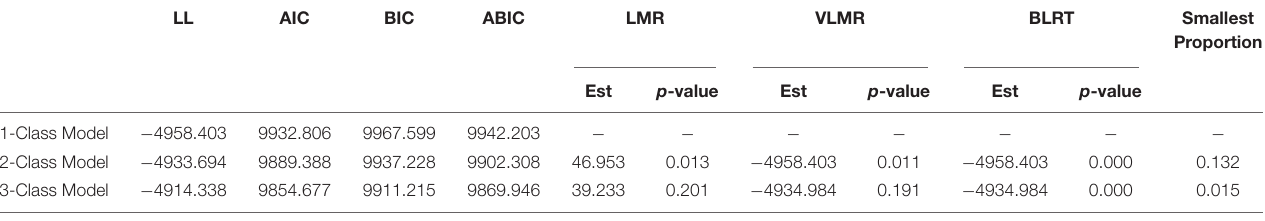
TABLE 2 | Model fit of 1-, 2-, and 3-class innovation capacities models for class enumeration. LL AIC BIC ABIC LMR VLMR BLRT Smallest Proportion Est p -value Est p -value Est p -value